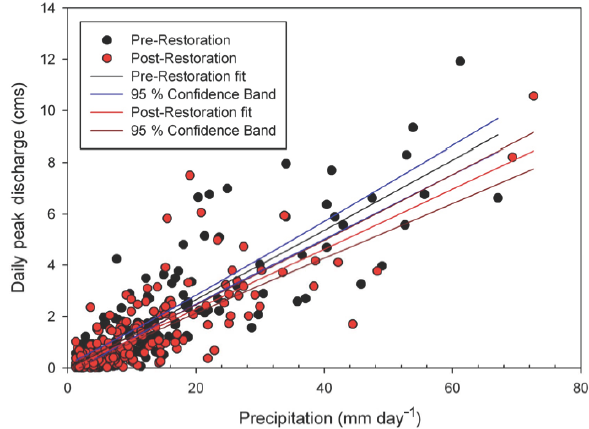
Figure 2. Effective precipitation and effective discharge for Minebank Run. Best-fit regression lines and 95% confidence lines